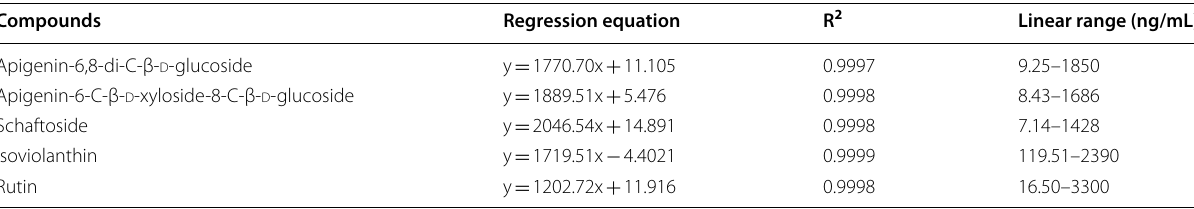
Table 2 Regression equation, correlation coefficient (R 2 ), linear range for 5 representative compounds from Dendrobium officinale